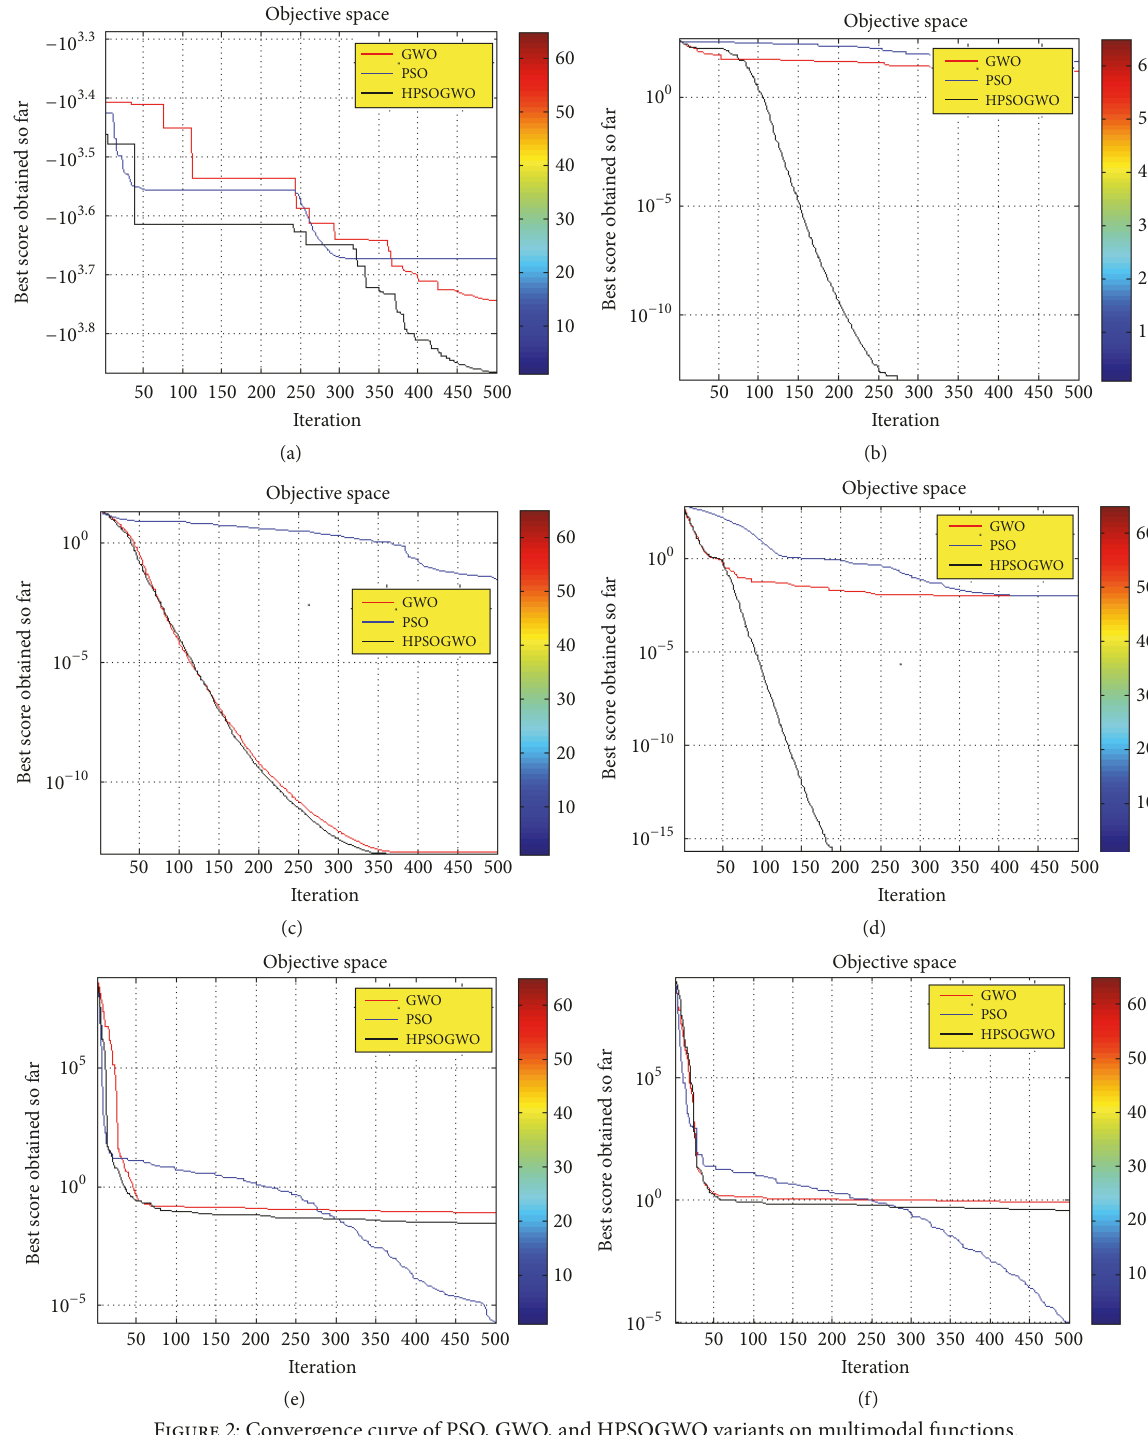
Figure 2: Convergence curve of PSO, GWO, and HPSOGWO variants on multimodal functions.